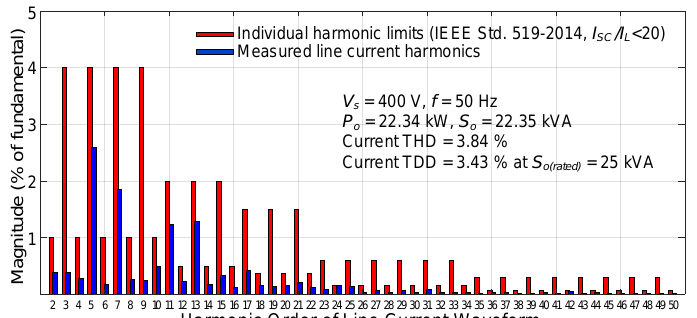
Figure 27. Sample harmonic spectra for the line current waveform injected by the inverter to the utility grid (deduced from the records of Hioki Power Analyzer PW3198 in Figure 26b). In this research work, the LCL filter is optimized to yield minimum filter size and hence cost. To illustrate the effects of LCL filter size on the harmonic distortion of line current waveforms, L g is